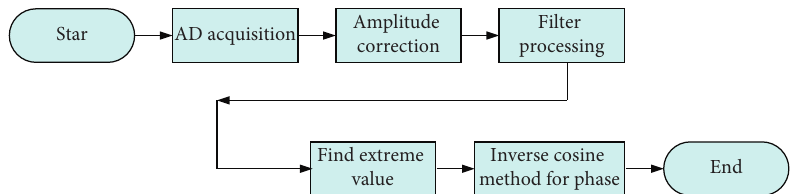
Figure 4: Flow chart of the phase detection algorithm.